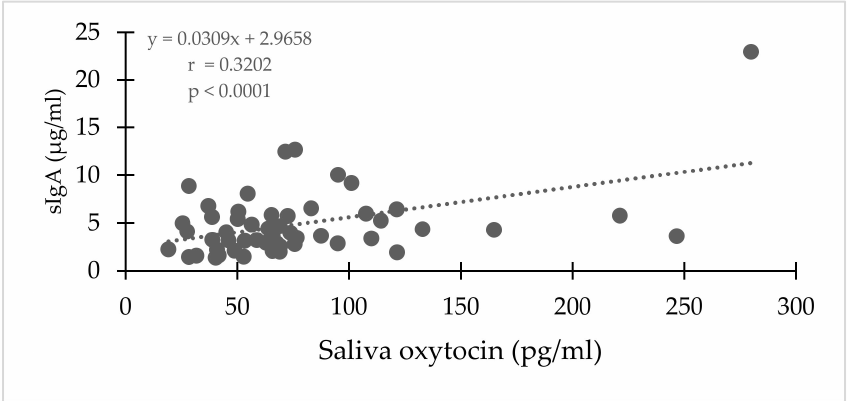
Figure 4. Correlation between secretory IgA and salivary oxytocin in bull Asian elephants during integration of two all-male